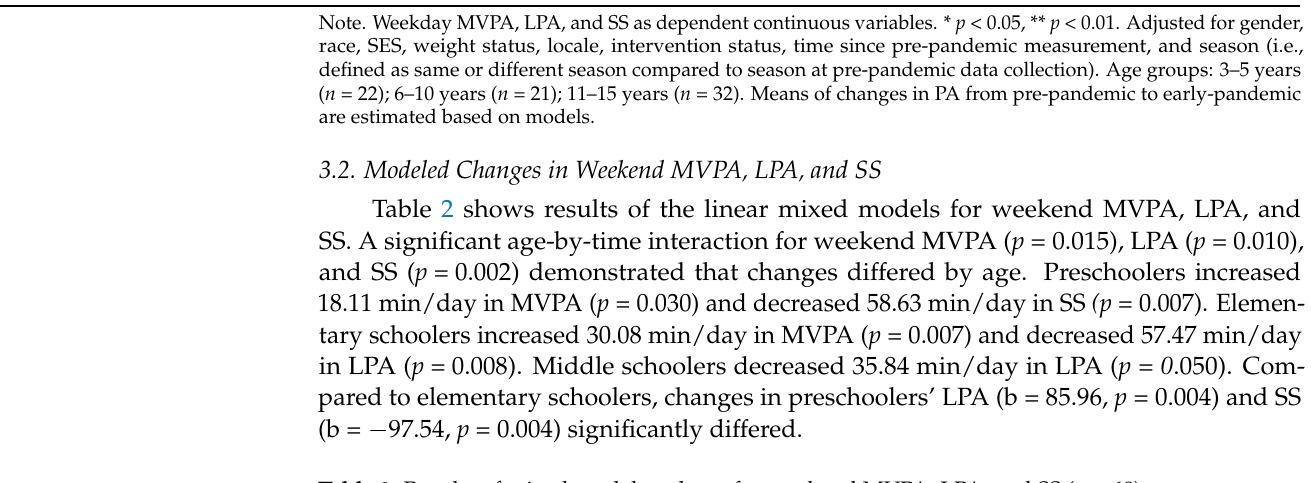
Table 2. Results of mixed model analyses for weekend MVPA, LPA, and SS ( n = 68). Model